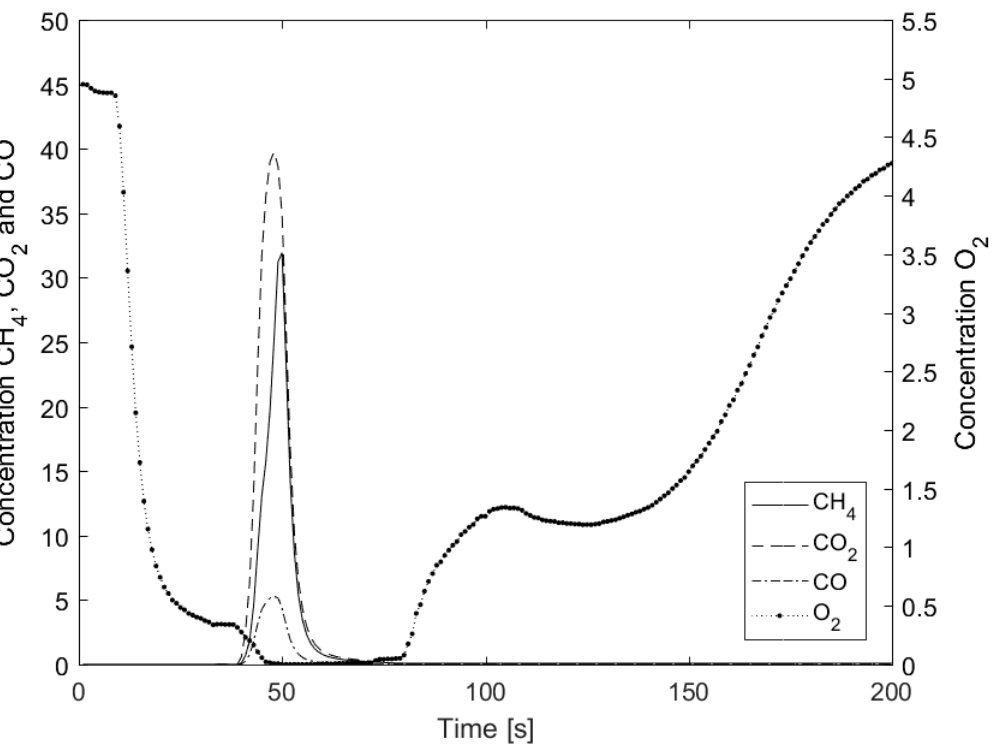
Figure 3. Example of obtained raw data logged from the Rosemount NGA-2000 dry gas analyzer. Data is logged every two seconds.